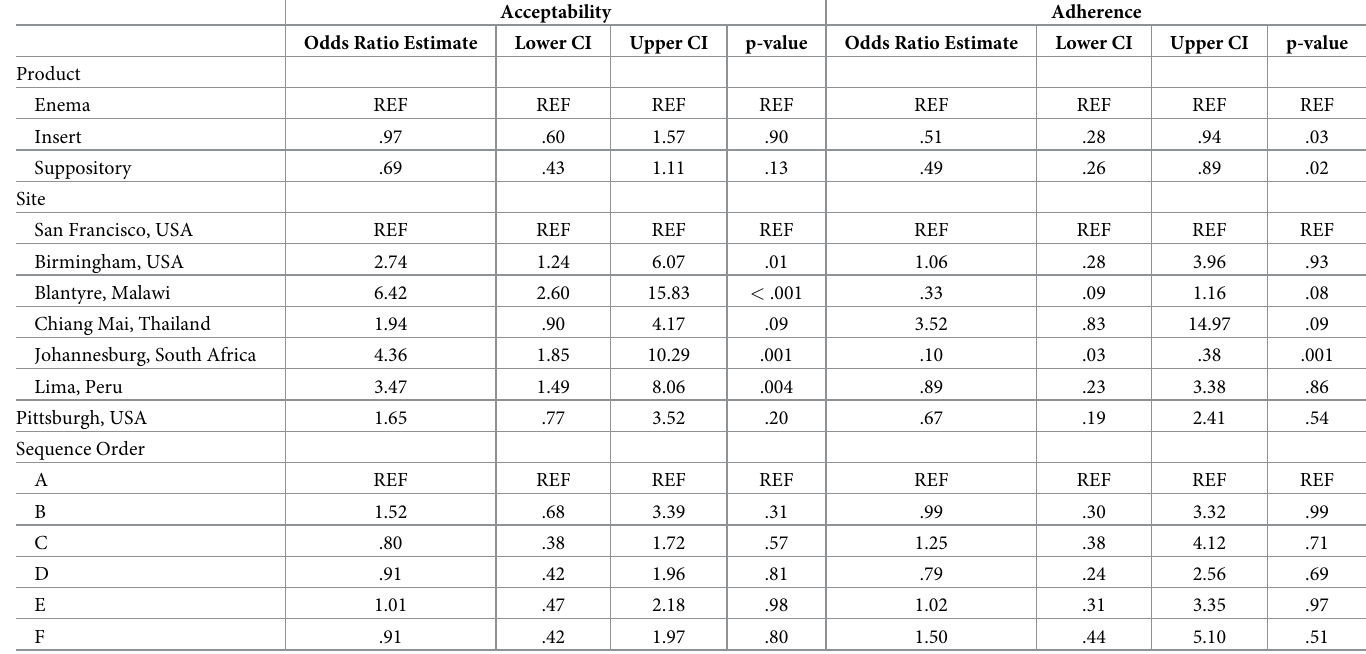
Table 5. Results from a linear mixed models with logistic link function estimating the odds ratio of reporting High (A) Acceptability to Study Product and (B) Adherence to Study product, for the Rectal Insert and Rectal Suppository, relative to the Rectal Enema, after accounting for site and sequence